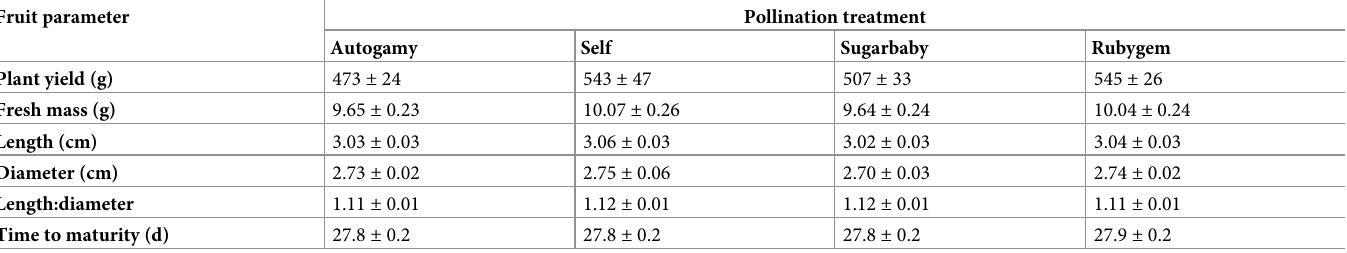
Means ± SE within a row are not significantly different (1-way ANOVA for yield and GLM for individual fruit parameters; P > 0.05; n = 10 plants for yield and n = 467– 532 fruit for other